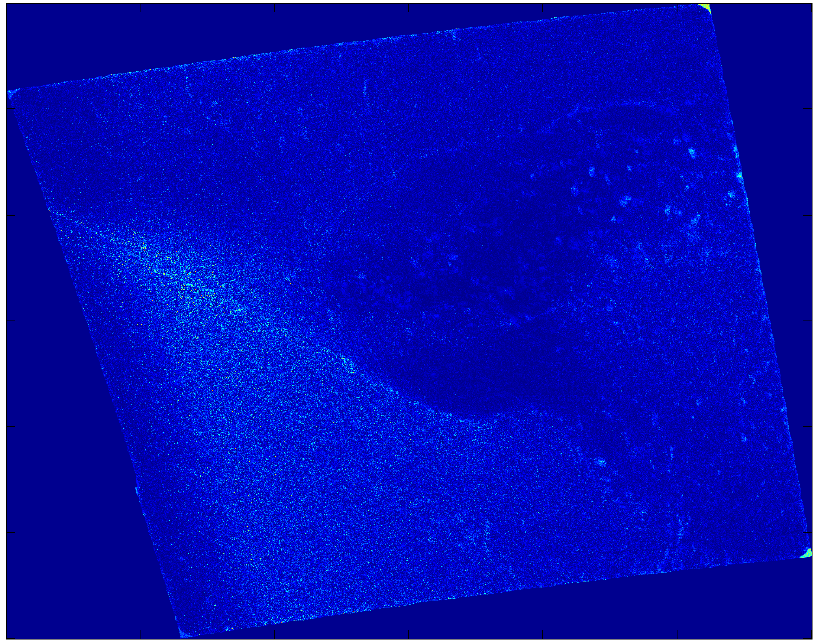
Figure 8. High-pass output of local median filter applied to the SDWS image for the case study, 0533 UTC on December 9, 2007. The two meandering bands of brighter blue speckles are the